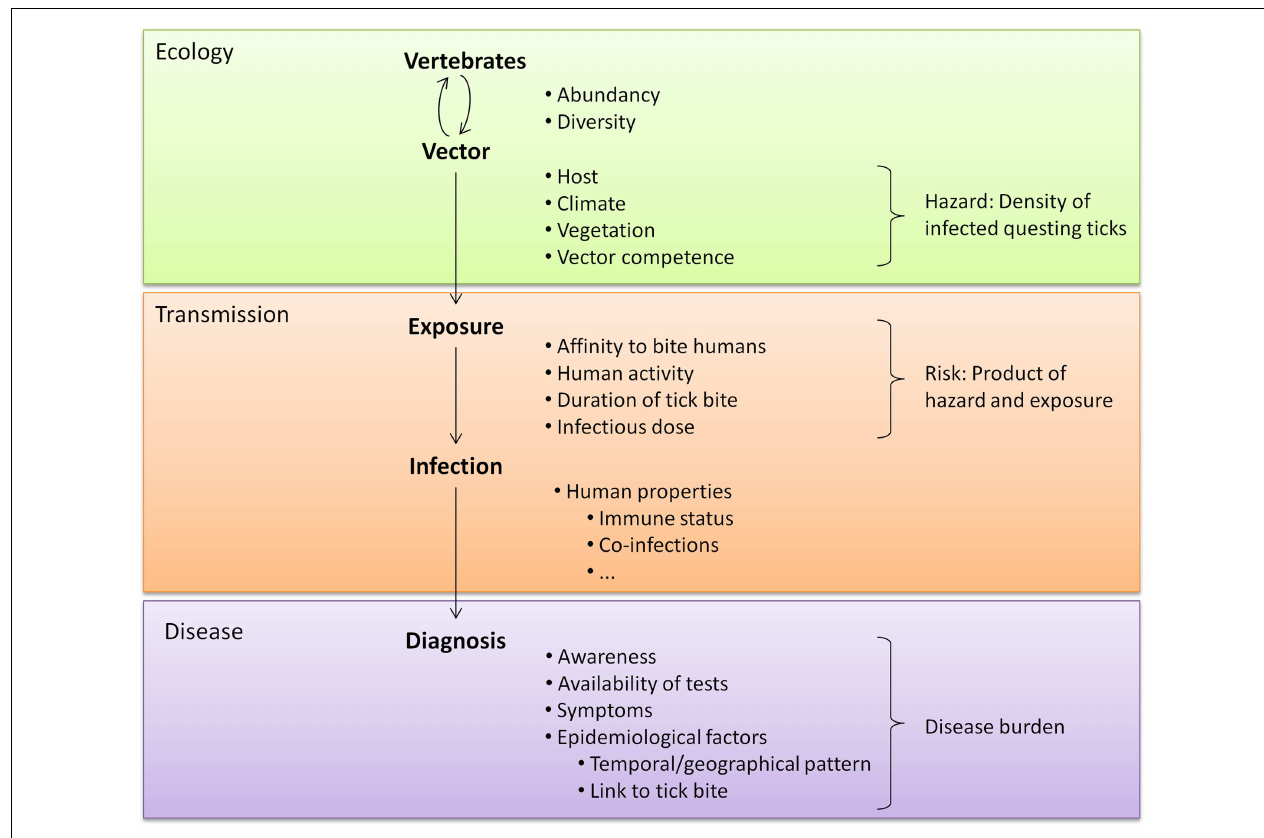
FIGURE 1 |A tick-related microorganism must take various steps to cause disease . Each step is influenced by many factors, including the characteristics of the microorganism.These characteristics affect every step of transmission and are therefore not listed